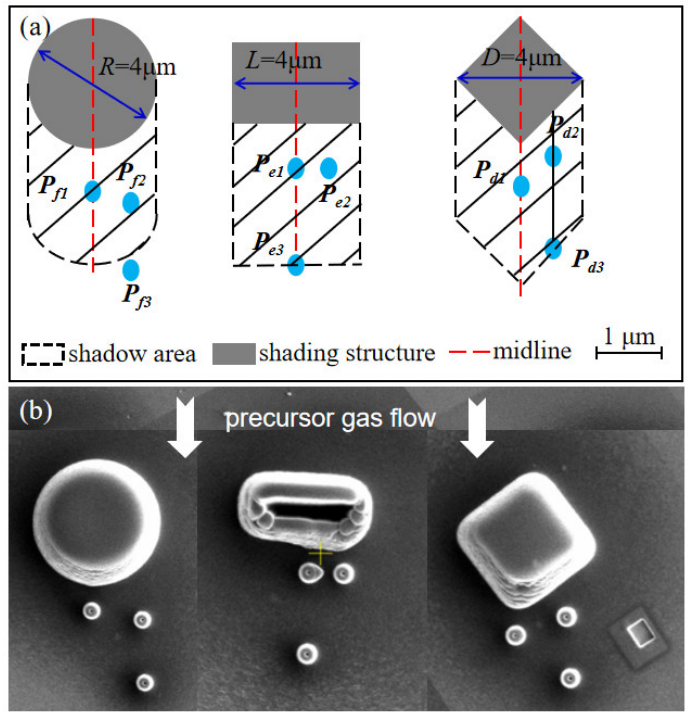
Figure 6. The ( a ) schematic, and ( b ) experimental results of three shading structures with different morphologies (circular, rectangular, diamond). The precursor gas flow direction is from the top to bottom.